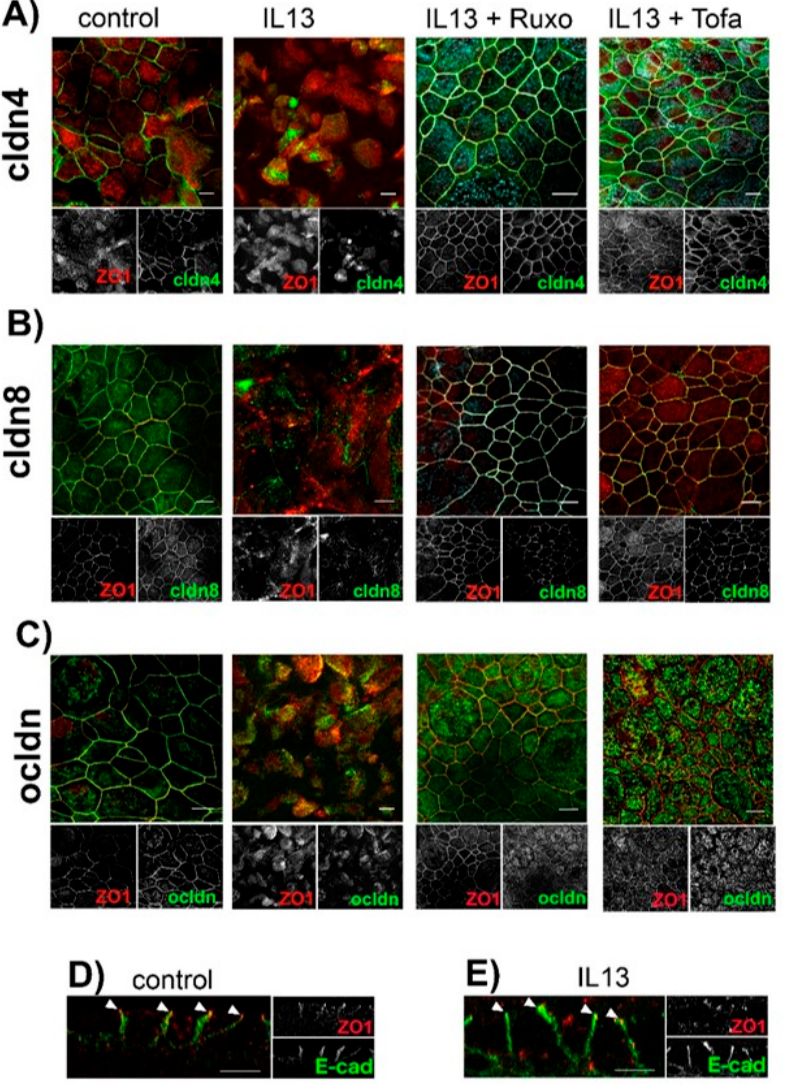
Figure 3. Effect of IL-13 on protein localization at TJ. Human tracheal epithelial cells were cultivated at air-liquid interface conditions. Epithelia were cultivated in the absence of compounds (control), in the presence of IL-13 (IL-13), in the presence of IL-13 + 2.5 µM S-Ruxolitinib (IL-13 + Ruxo) or in the presence of 2.5 µM Tofacitinib (IL-13 + Tofa). Scale bars represent 10 µm. ( A ) Intracellular localization of claudin 4 (cldn4, green channel). Zonula occludens 1 (ZO1, red channel) was used for counterstaining for tight junctions. ( B ) Intracellular localization of claudin 8 (cldn8, green channel). Counterstaining for tight junctions by ZO1 (red channel). ( C ) Intracellular localization of occludin (ocldn, green channel). Counterstaining for tight junctions by ZO1 (red channel). ( D ) and ( E ) Intracellular localization of E-cadherin (E-cad, green channel) as a marker for lateral adherens junction. ZO1 (red channel) was used for counterstaining of tight junctions.